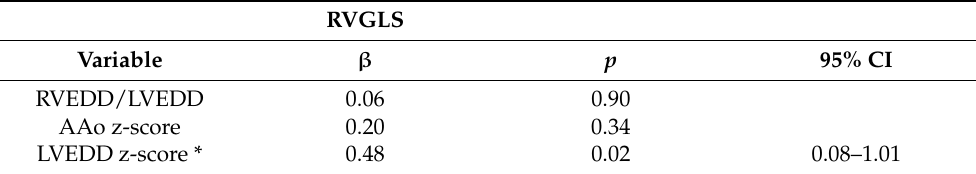
Table 5. Multivariate regression analysis for RV myocardial deformation parameters in HLHS